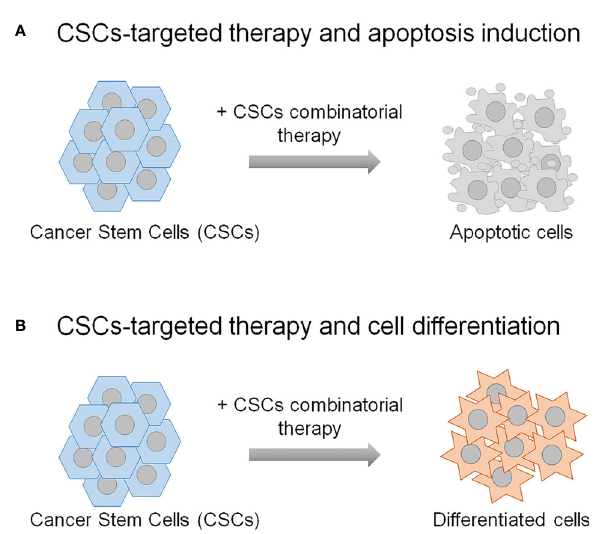
FIGURE 2 | The schematic representation shows the mechanisms underlying the CSCs combinatorial strategies applied in the preclinical studies described in the text. CSCs-targeting can result in their eradication (A) , or differentiation (B) . The remaining non-stem tumor cells are thought to be sensitive to the conventional chemo- and